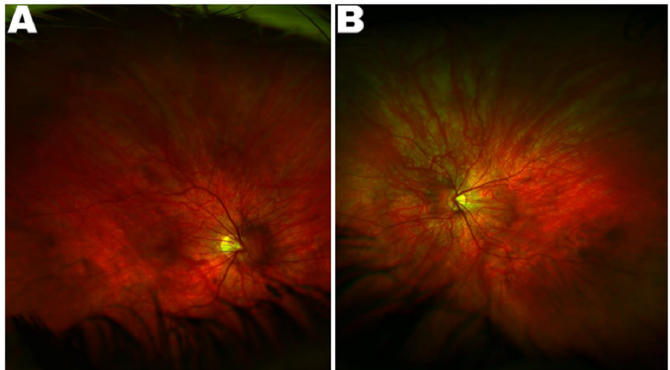
Figure 1. Ultrawide-field color fundus photograph of proband’s right eye ( A ) and left eye ( B ) showing hypopigmented fundus with peripapillary atrophy.